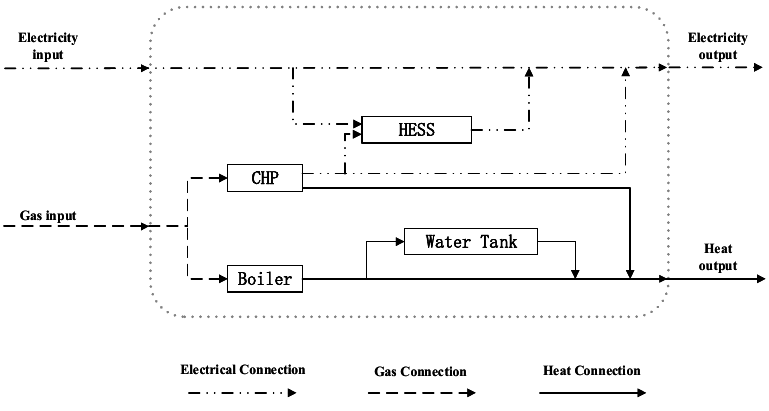
Figure 2. Energy flow in smart building. Table 1. List of all parameters and values used through the paper.